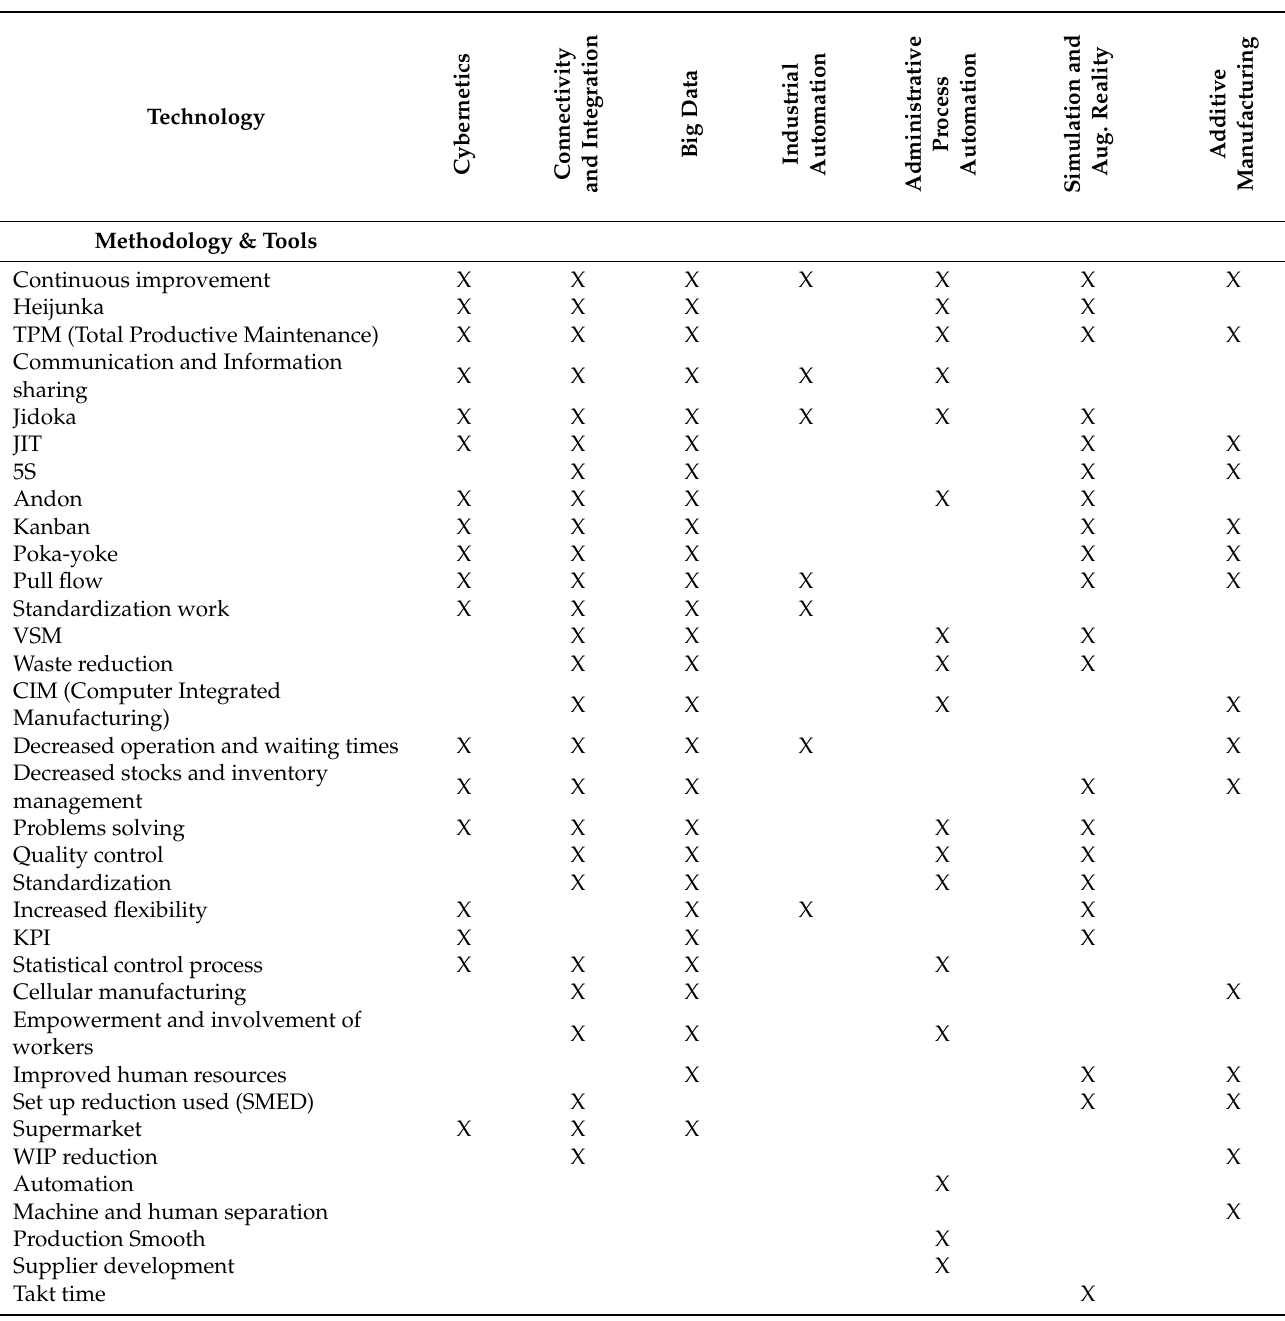
Table 7. Analysis of the article “Impacts of Industry 4.0 technologies on Lean management tools: a bibliometric analysis”